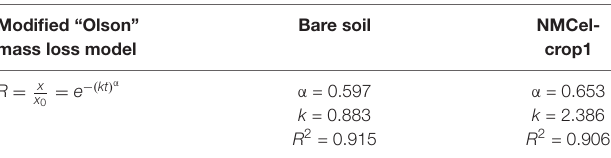
TABLE 3 | Modified “Olson” mass loss model in the field decomposition